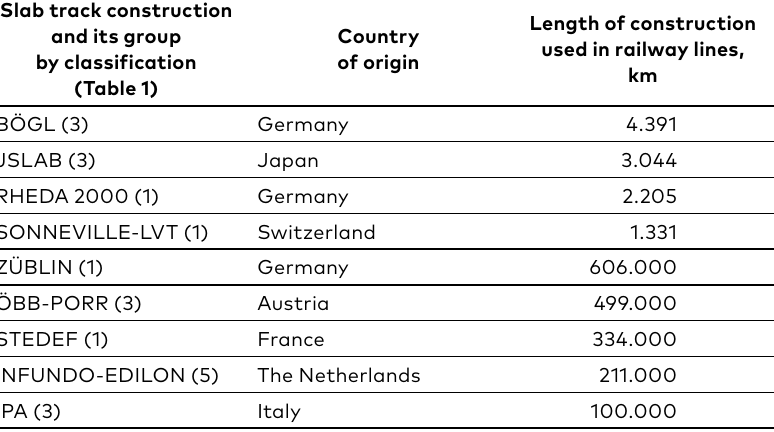
Table 2. Use of slab track